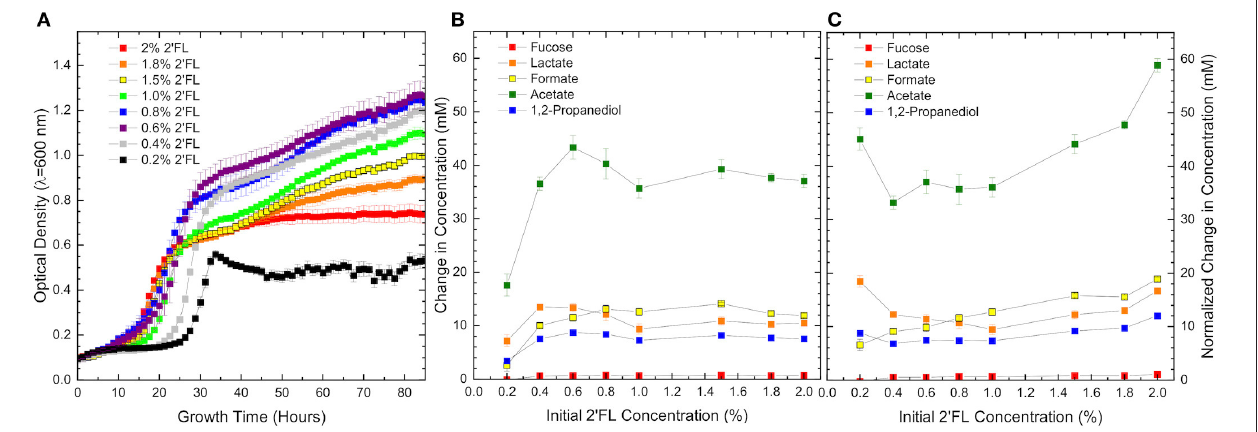
FIGURE 3 | Growth curves of ATCC 15697 growth on (A) 2 ′ fucosyllactose as a sole carbohydrate source is highly concentration-dependent. Metabolite production (B) appears to be consistently dependent on 2 ′ fucosyllactose concentration, but concentration dependence does not persist when (C) metabolite concentrations are normalized to account for differences in biomass. Error bars denote standard error of the mean.